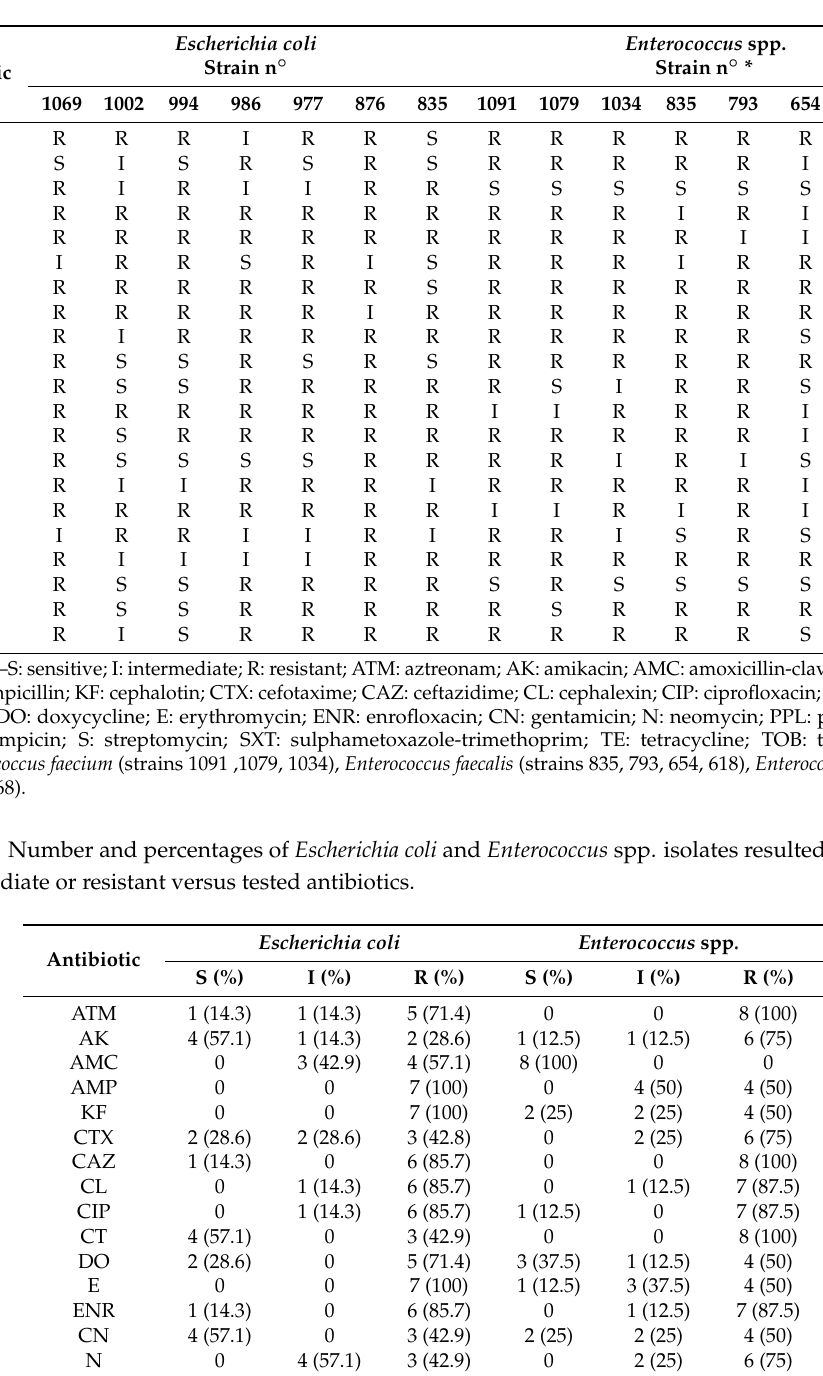
Table 2. Results of the agar disc diffusion method testing each Escherichia coli and Enterococcus spp. isolates with different antibiotics.